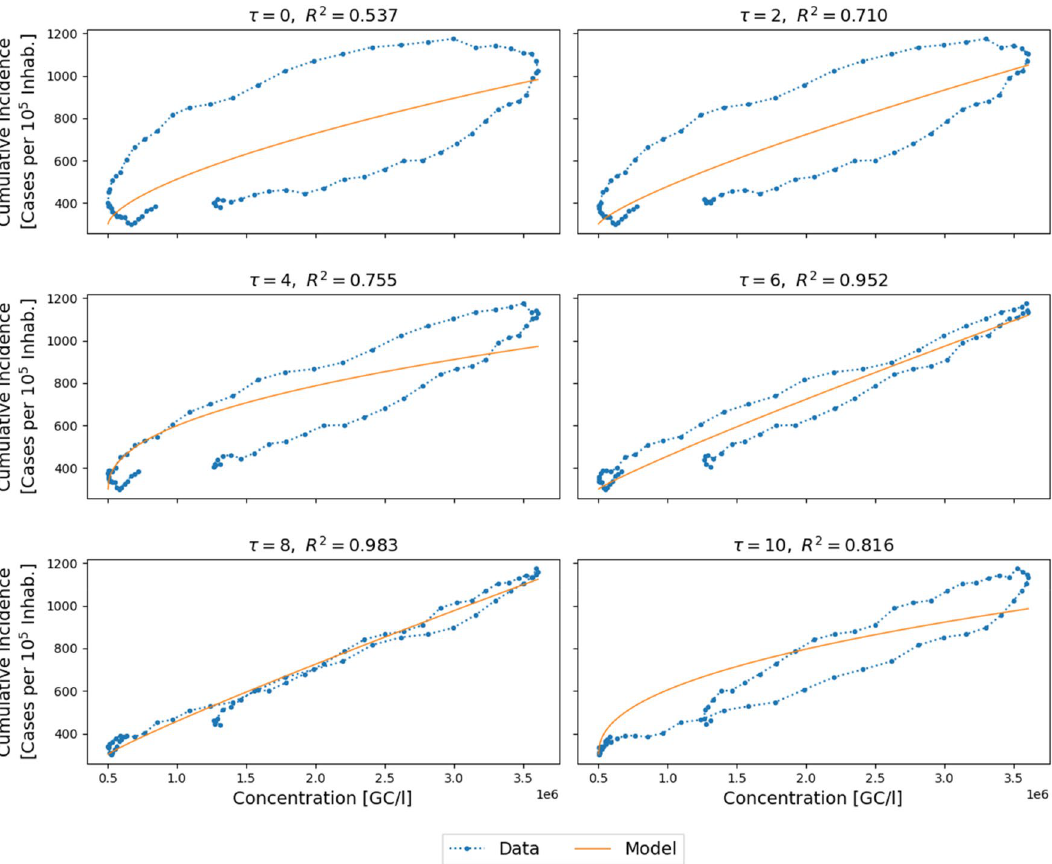
Figure 2. Cumulative incidence as a function of concentration of genetic copies for different values of the delay parameter τ [days] together with the corresponding fitted functions and R the interpolated cumulative incidence and the smoothed concentration data, and the orange solid line shows the adjusted model. Data correspond to WWTP22 (Rubí) during the autumn wave